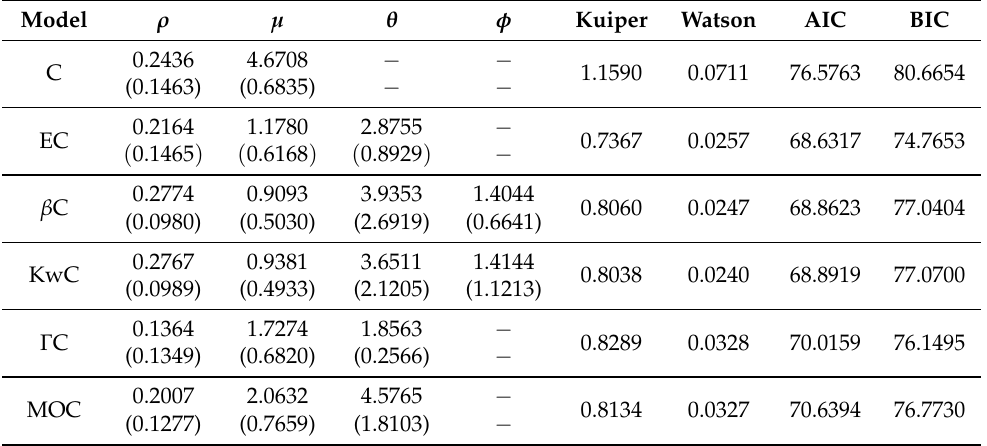
Table 3. MLEs of the parameters for the first dataset, their standard errors (given in parentheses), and the Kuiper, Watson, AIC, and BIC statistics.